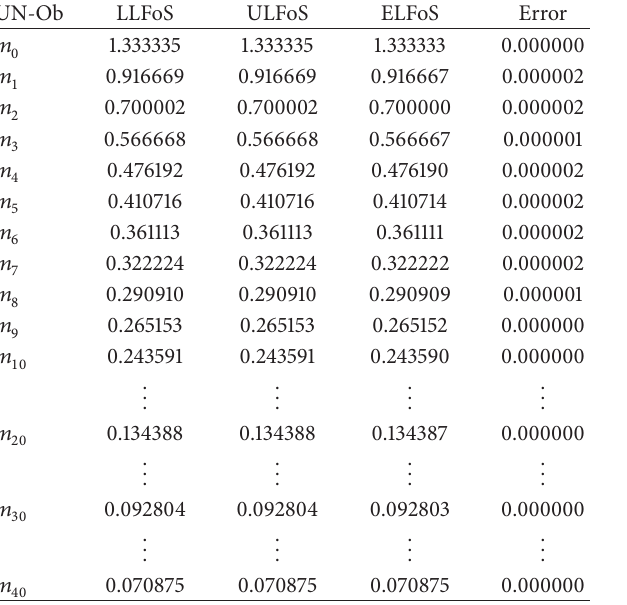
Table 5: Upper and lower bounds for Example 4 for 𝑁 = 50